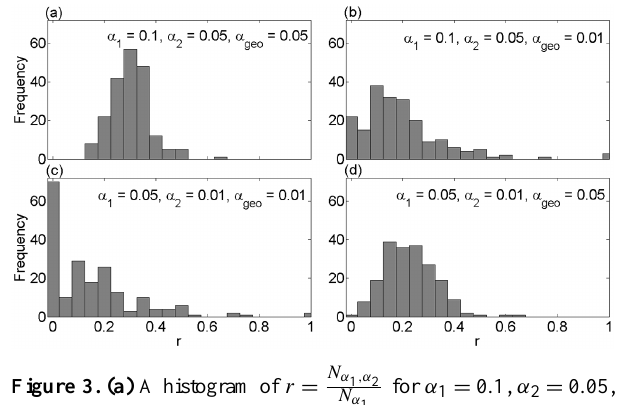
N α 1 ,α 2 Figure 3. (a) A histogram of r = for α 1 = 0 . 1, α 2 = 0 . 05, N α 1 and α geo = 0 . 05 obtained from the generation of 300 wavelet power spectra of red-noise processes of length 1000 with lag-1 auto- correlation coefficients equal to 0.5. (b) Same as (a) but with α geo = 0 . 01. (c) Same as (a) but with α 1 = 0 . 05, α 2 = 0 . 01, and α geo = 0 . 01. (d) Same as (c) but with α geo = 0 .